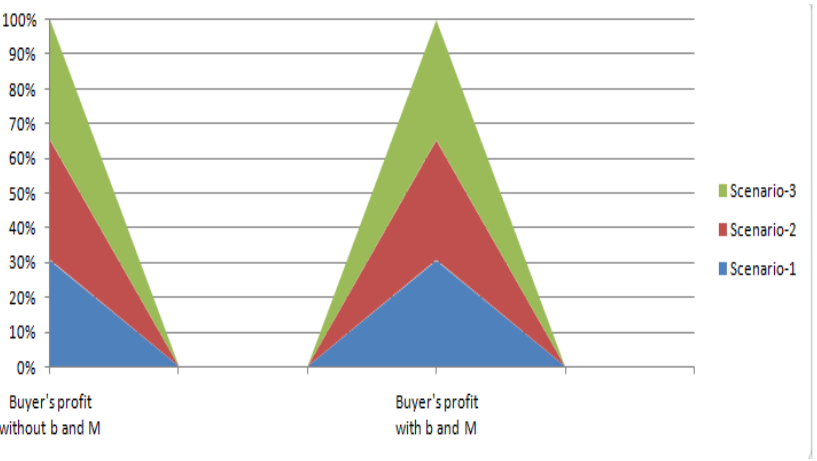
Figure 11. With and without the effect of learning and trade credit period on total profit. Table 2. Comparison of crisp and fuzzy environment. Table 2. Comparison of crisp and fuzzy